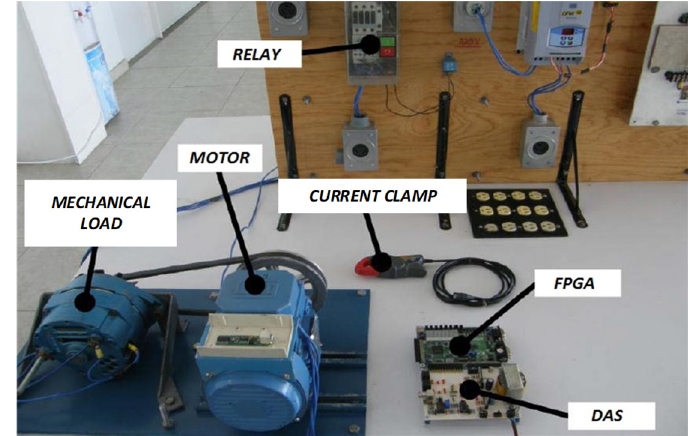
Figure 2. Experimental setup.